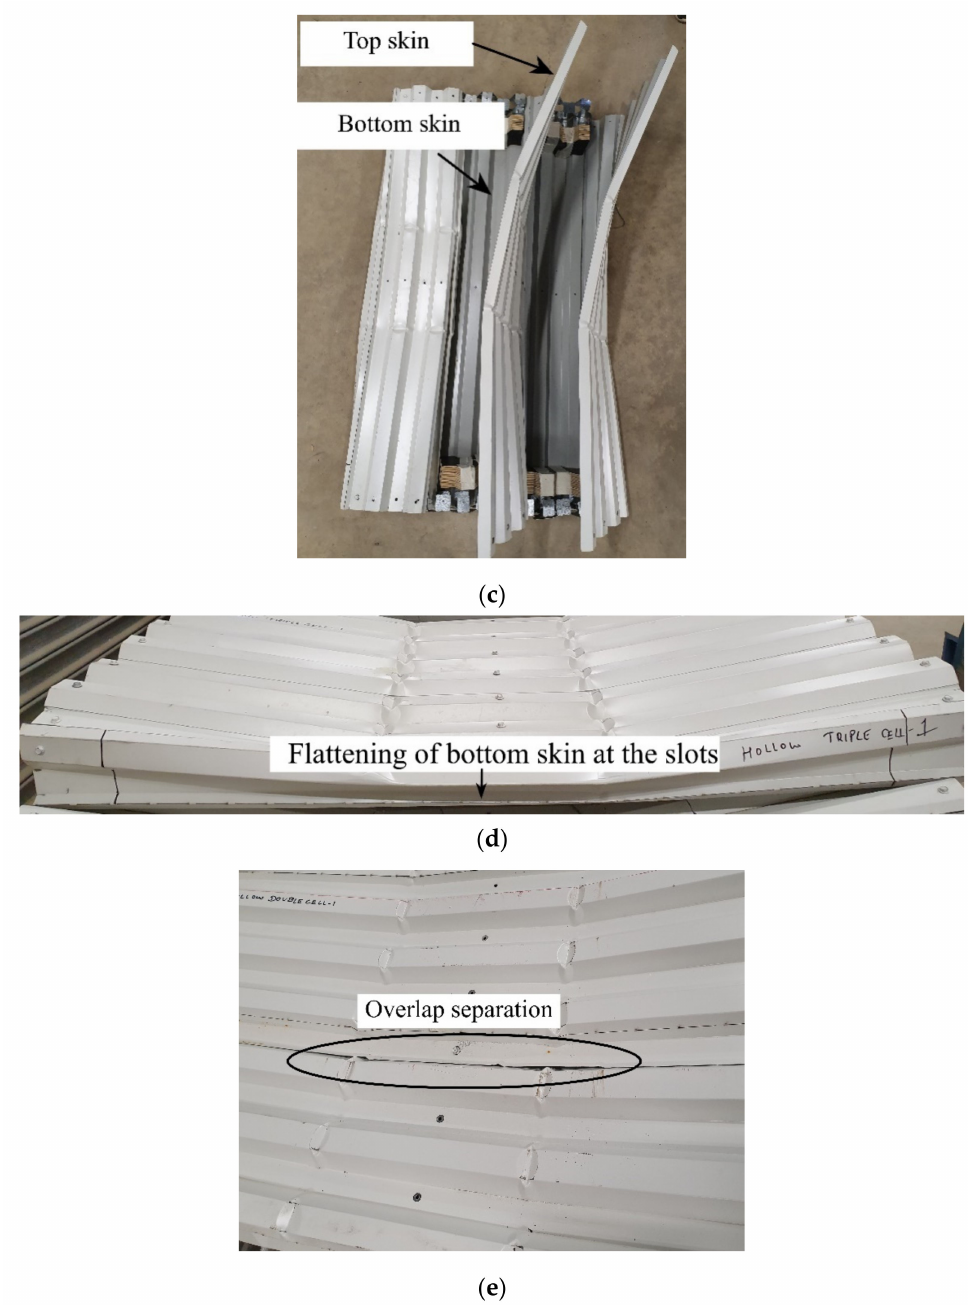
Figure 9. ( a ) Failed double cell panel. ( b ) Local buckling in triple cell panel. ( c ) Open triple cell sample with the intact bottom skin. ( d ) Flattening of bottom skin at slots. ( e ) Separation at the overlap of double